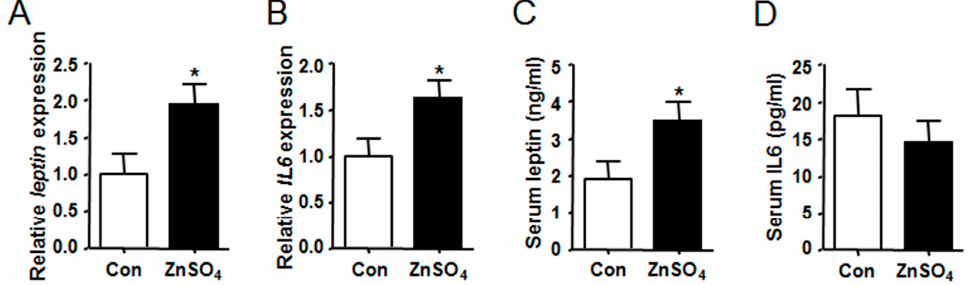
Figure 3. Chronic zinc supplementation stimulated the expression and secretion of leptin in perirenal